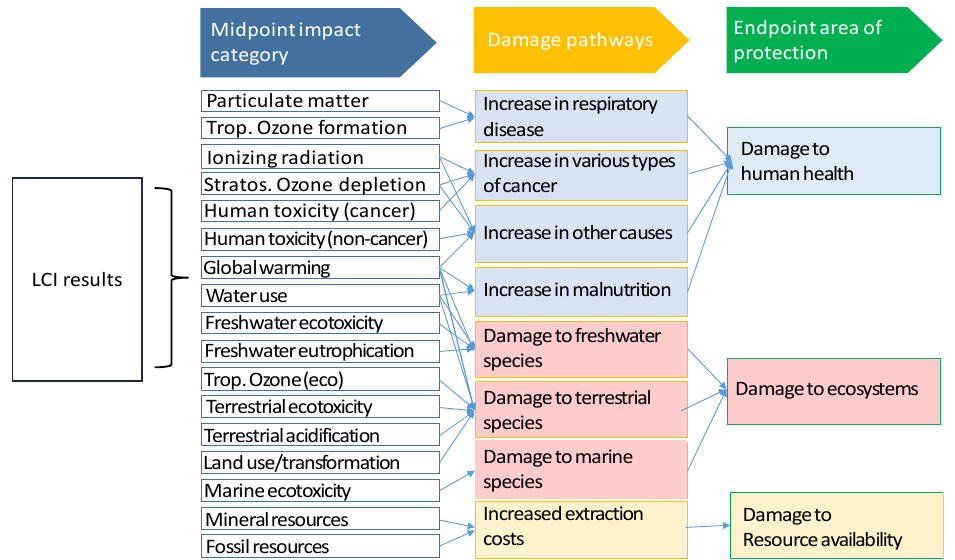
Figure 3. Overview of the impact categories that are covered in the ReCiPe2016 method and their relation to the areas of protection (adapted from [25]).